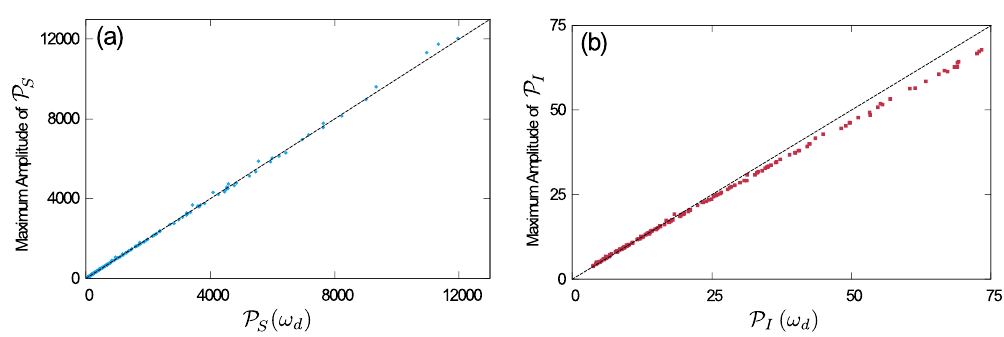
Figure 5. Verification of approximation (19) for the peak-height of the spectral densities. Horizontal axes show the prediction of Eq. (19) for susceptibles (a) , and infectives (b) . On the vertical axis we show the height at the peak of the spectra, as determined numerically from Eq. (S10) in the Supplement. Black dashed lines are the diagonal (‘ y = x ’), and markers represent the populations described in Fig.